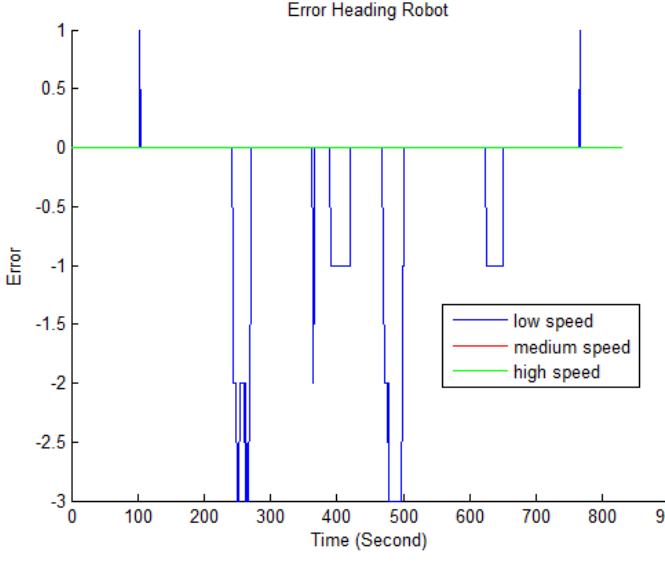
Figure 21. Heading Robot